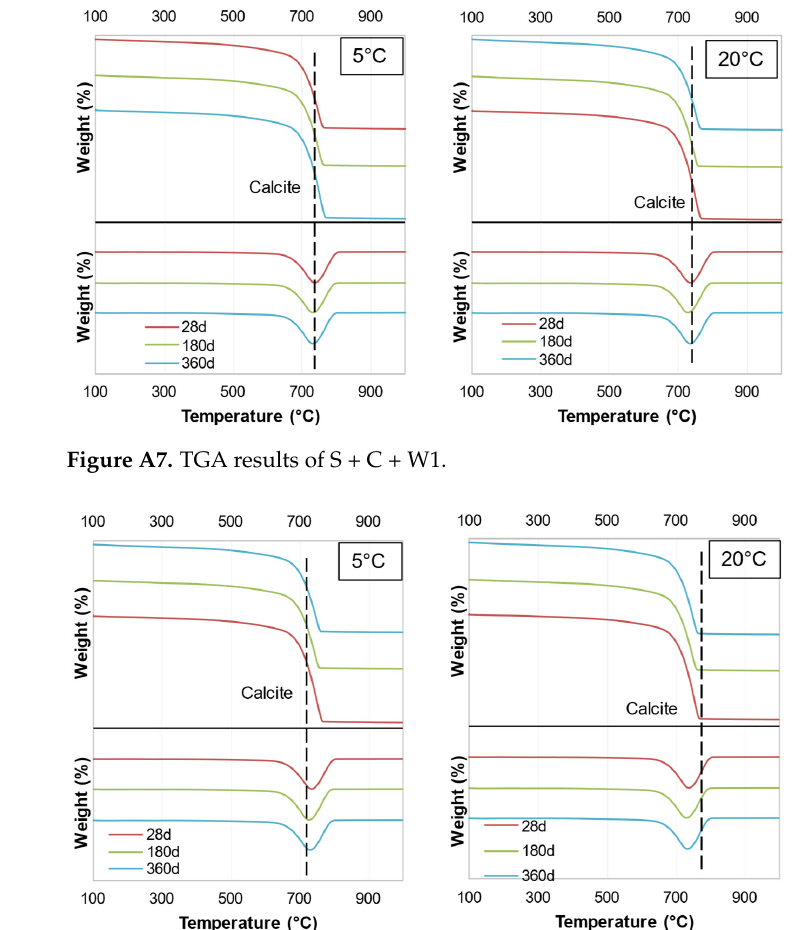
Figure A8. TGA results of S + C + W3.